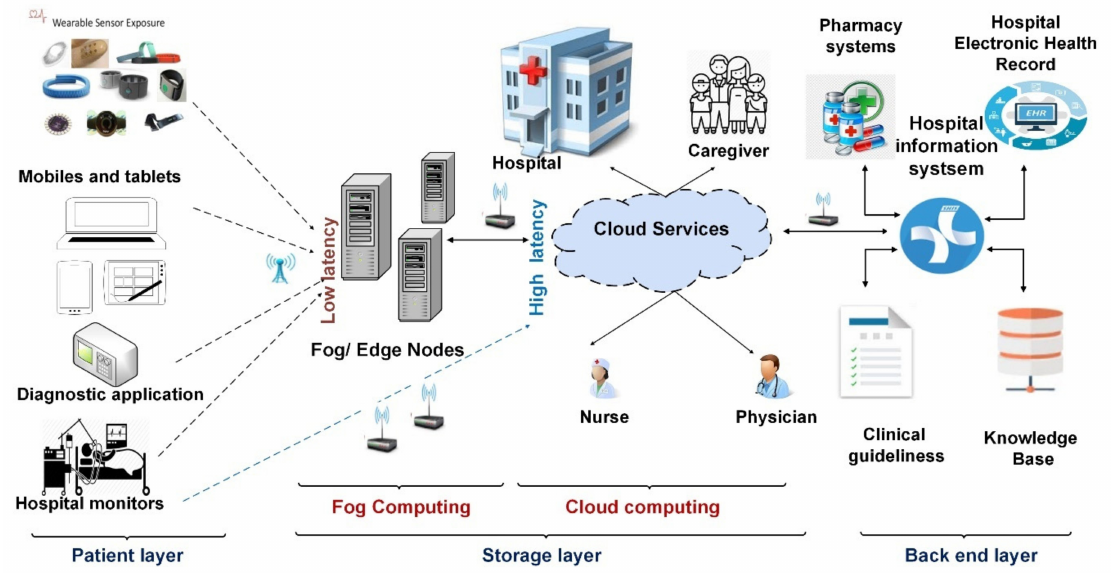
Figure 3. The general architecture of